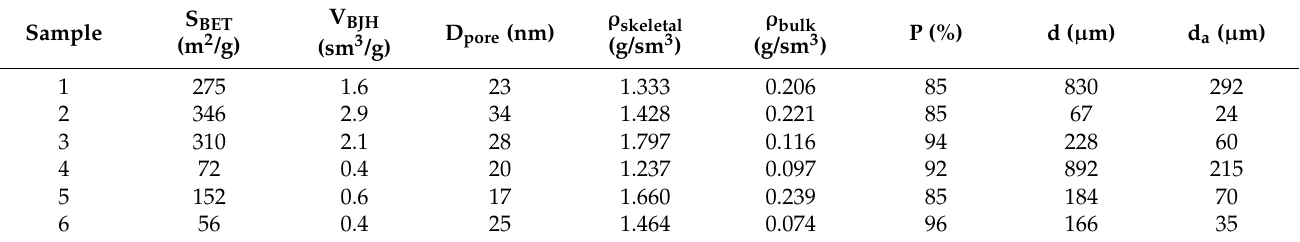
Table 1. Characteristics of the protein